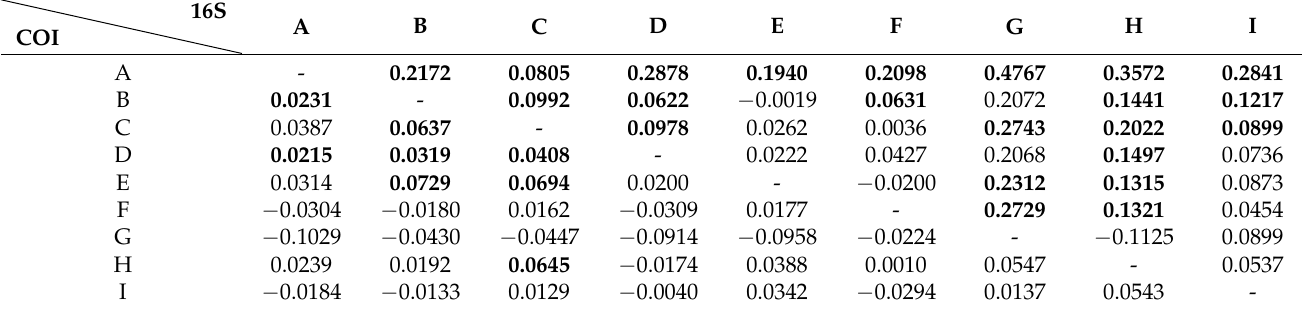
Table 4. Population pairwise F ST for COI (bottom left) and 16S rRNA gene (top right) for the hilly lineage of